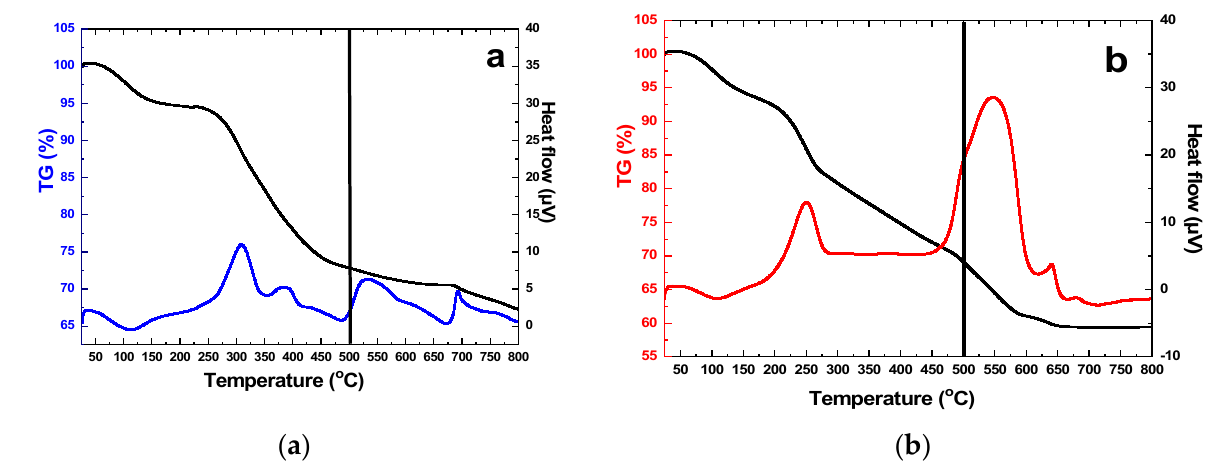
Figure 2. DTA/TG curves of the dried precursor mixtures A ( a ) and B ( b ).